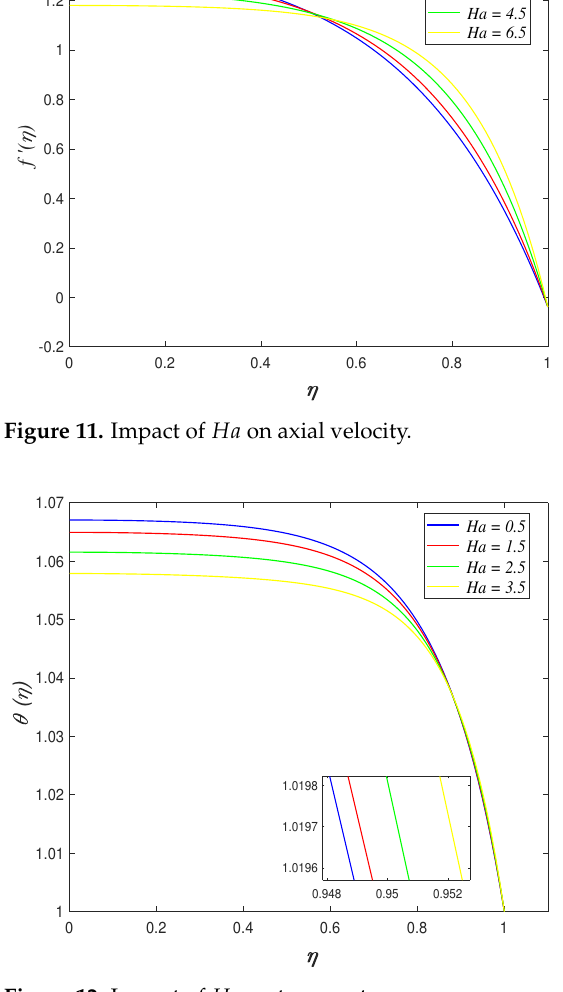
Figure 12. Impact of Ha on temperature.